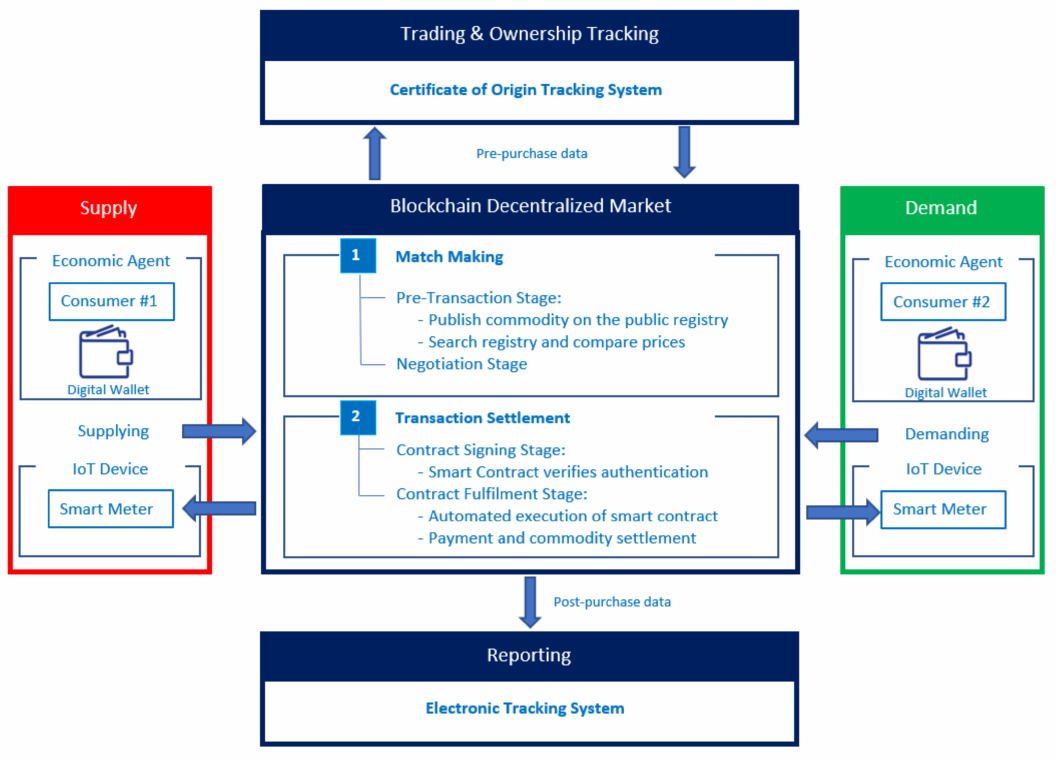
Figure 4. Trading model